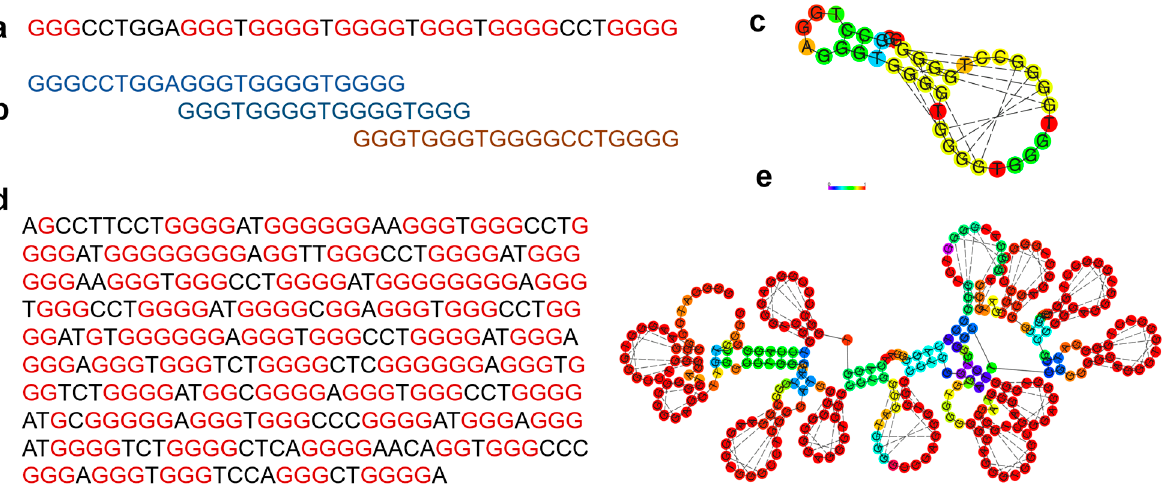
Figure 8. Example sequences with multiple tetrads. ( a ) G-quadruplex sequence from chr19:43479561-43479598 overlapping the PHLDB3 gene with guanines labeled in red. ( b ) Three possible alternate G4 regions for the PHLDB3 region. ( c ) MFE structure for the PHLDB3 region. ( d ) G-quadruplex sequence from chr17:81432609-81432932 overlapping the BAHCC1 gene with guanines labeled in red. ( e ) MFE structure for the BAHCC1 gene.